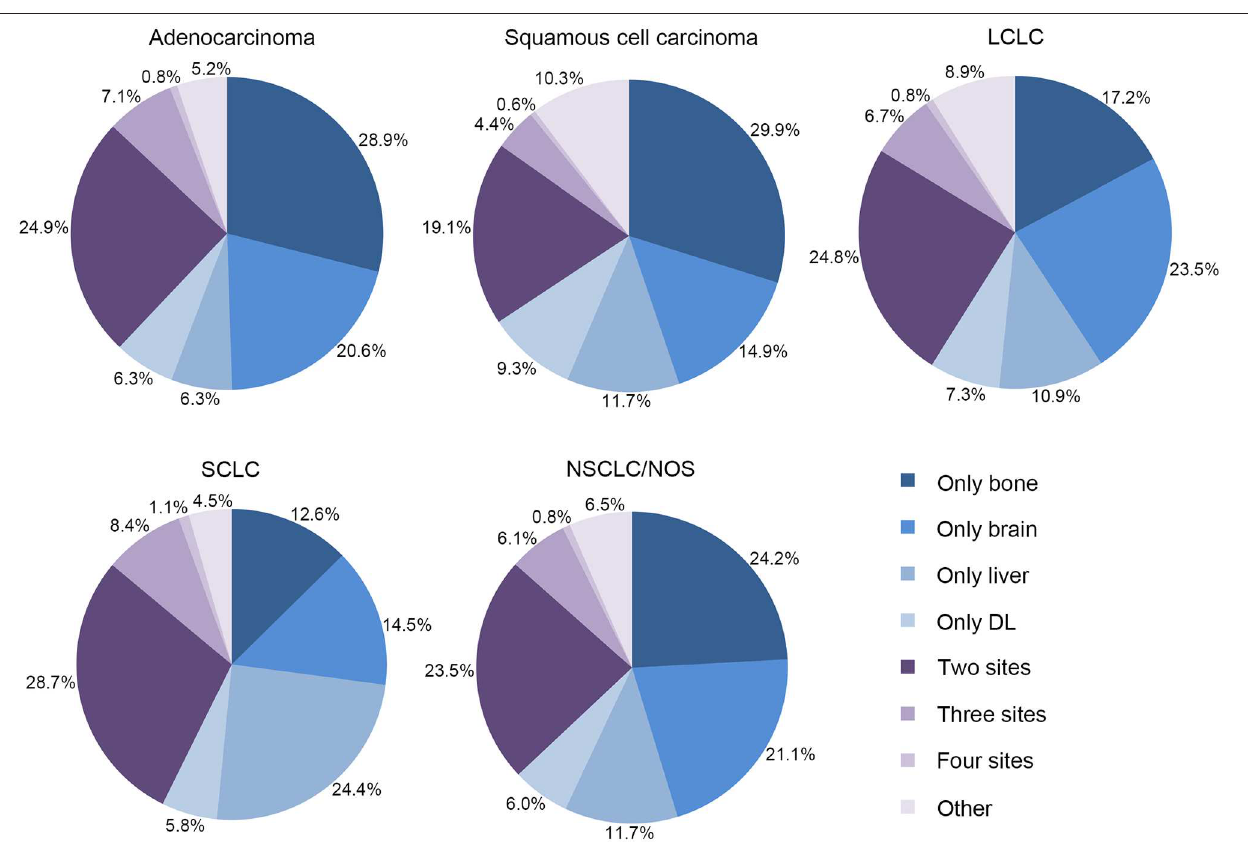
Frontiers in Oncology |